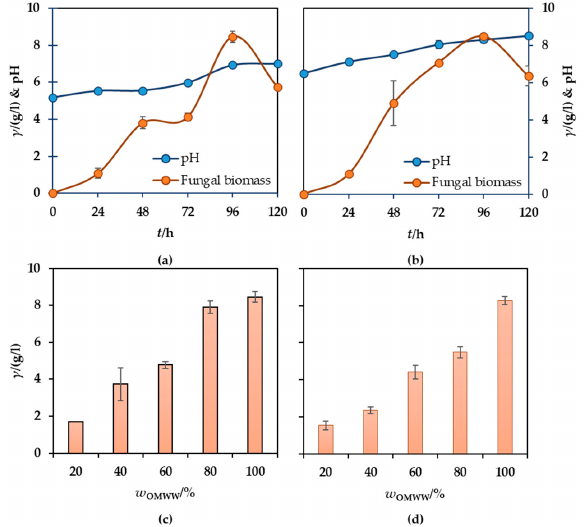
Figure 3. ( a ) Profiles of biomass mass concentration and pH during cultivation of A. oryzae in undiluted OMWW at initial pH of 5.2; ( b ) Profiles of biomass mass concentration and pH during cultivation of A. oryzae in undiluted OMWW at initial pH of 6.5; ( c ) Fungal biomass mass concentration